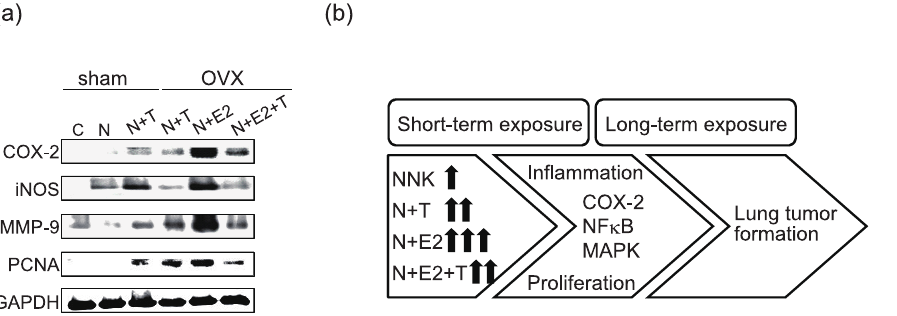
Figure 5. The inflammatory and proliferative protein expression pattern in the long-term exposure groups. (a) Lung homogenates were collected and analyzed for the expression of the inflammatory markers COX-2 and iNOS, proliferative marker PCNA, and MMP-9 by western blot analysis. (b) A model for the synergistic effects of NNK + E2, or NNK + TCDD on lung inflammation and tumor formation. Sham: sham-operated, OVX: ovariectomized, C: control, N + T: NNK + TCDD, N + E2: NNK + E2 (17 b -estradiol), N + E2 + T: NNK + E2 +